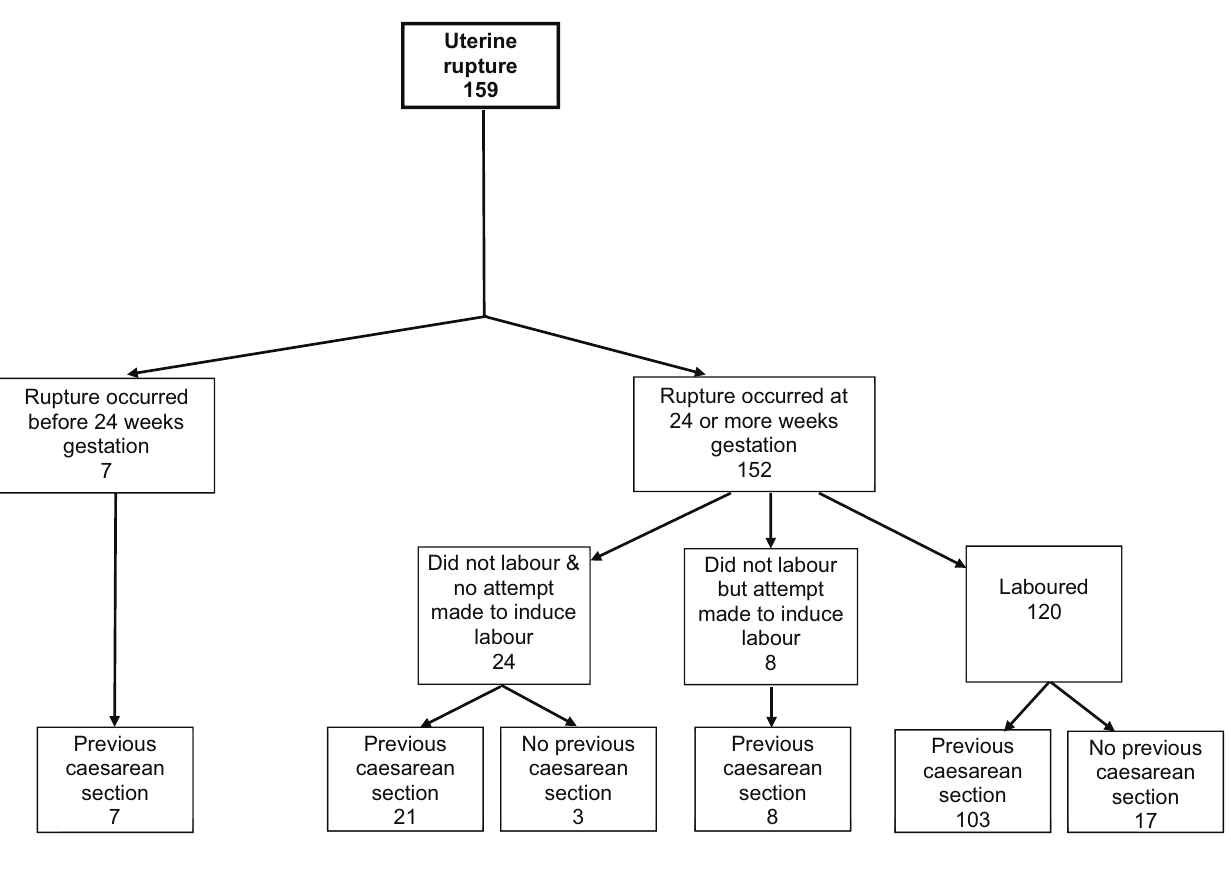
Figure 2. Uterine rupture cases by gestational age at rupture, labour, and previous caesarean section status.